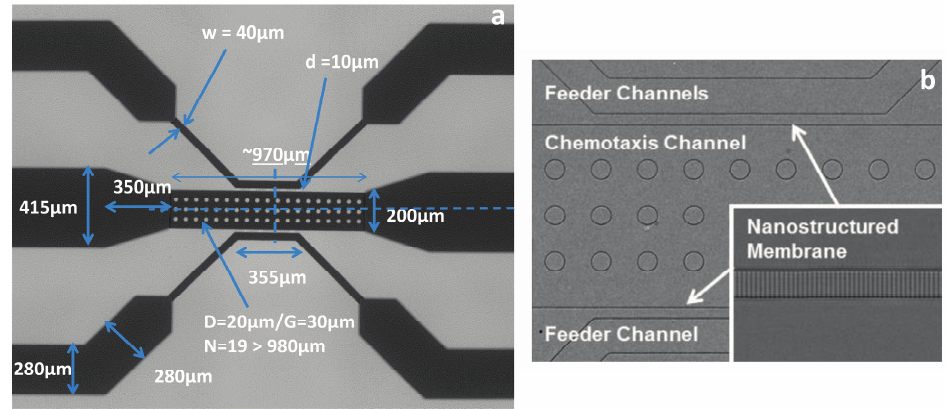
Figure 2. Microfluidic device dimensions. ( a ) SEM image of the microfluidic